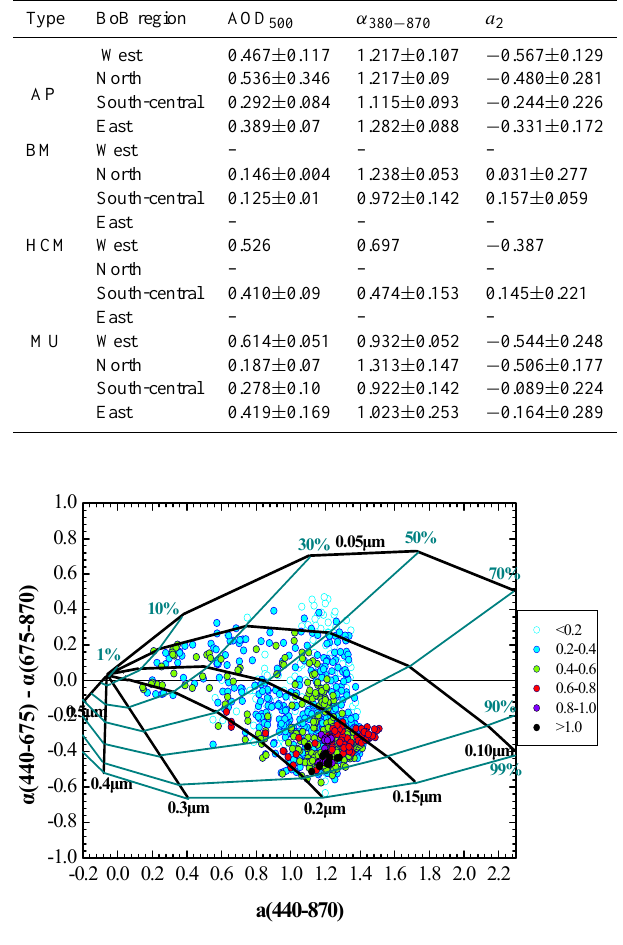
Fig. 9. ˚Angstr¨om exponent difference, dα = α ( 440 − 675 ) – α ( 675 − 870 ) , as a function of α 440 − 870 and AOD 500 (color scale) over en- tire BoB. The black lines indicate the R eff of fine-mode aerosols, while the cyan lines correspond to fine-mode fraction ( η